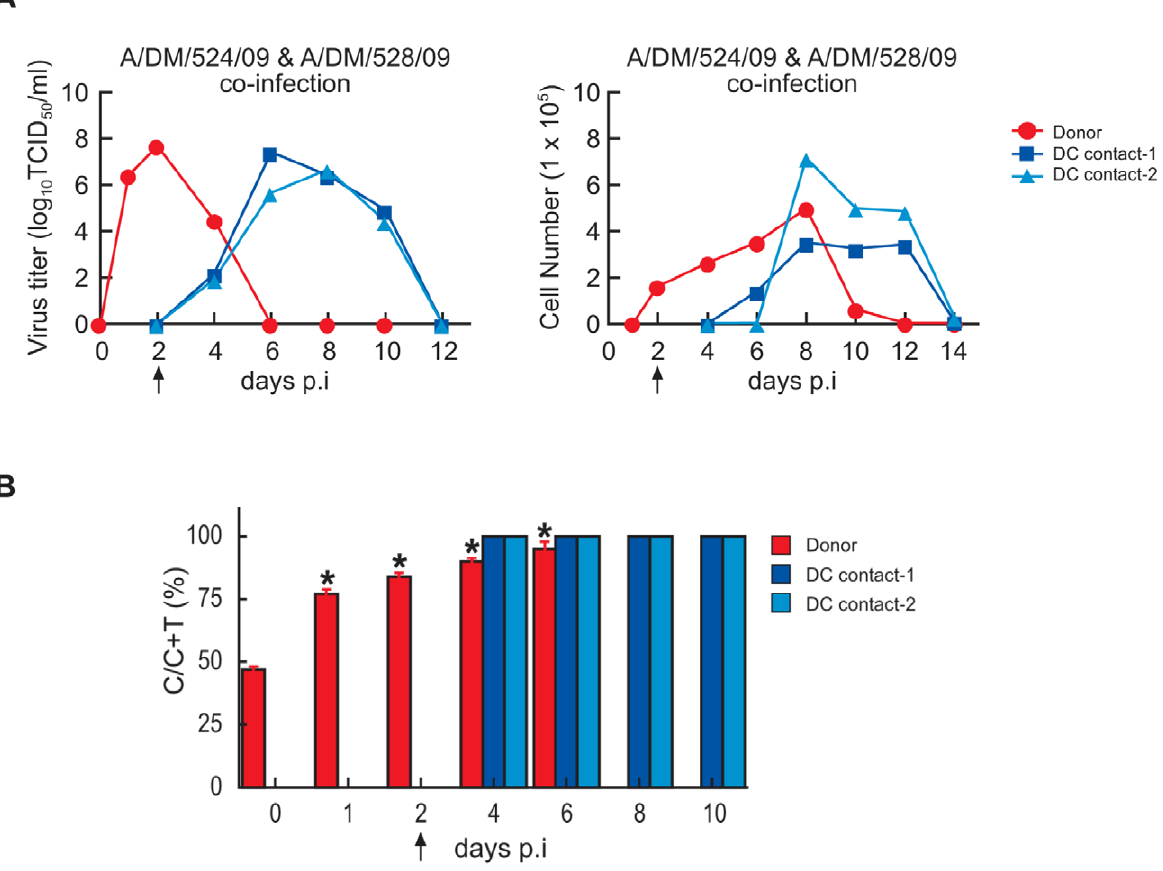
Figure 3. Co-infection in a ferret with oseltamivir-sensitive and -resistant H1N1/2009 influenza viruses. Virus titers and inflammatory cell counts in the nasal wash specimens of ferrets co-inoculated with oseltamivir-sensitive and -resistant H1N1/2009 viruses (A). The arrow indicates the first day of exposure of contact ferrets. The proportion of wild-type virus (C in SNP sequence) in the mixed virus population (C + T in SNP sequence) in nasal wash samples from the donor ferret and two direct-contact ferrets (B). Values are the mean 6 SD from three independent measurements. * P , 0.05 compared to value for day 0 p.i. doi:10.1371/journal.ppat.1001022.g003 PLoS Pathogens |